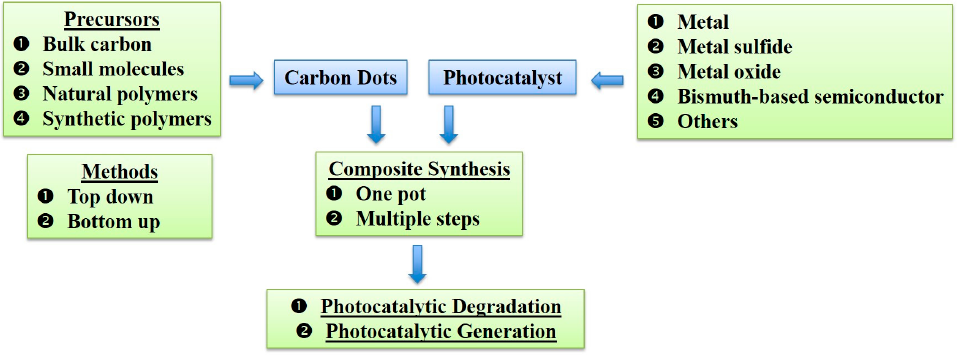
Figure 1. Overall structure of the article.